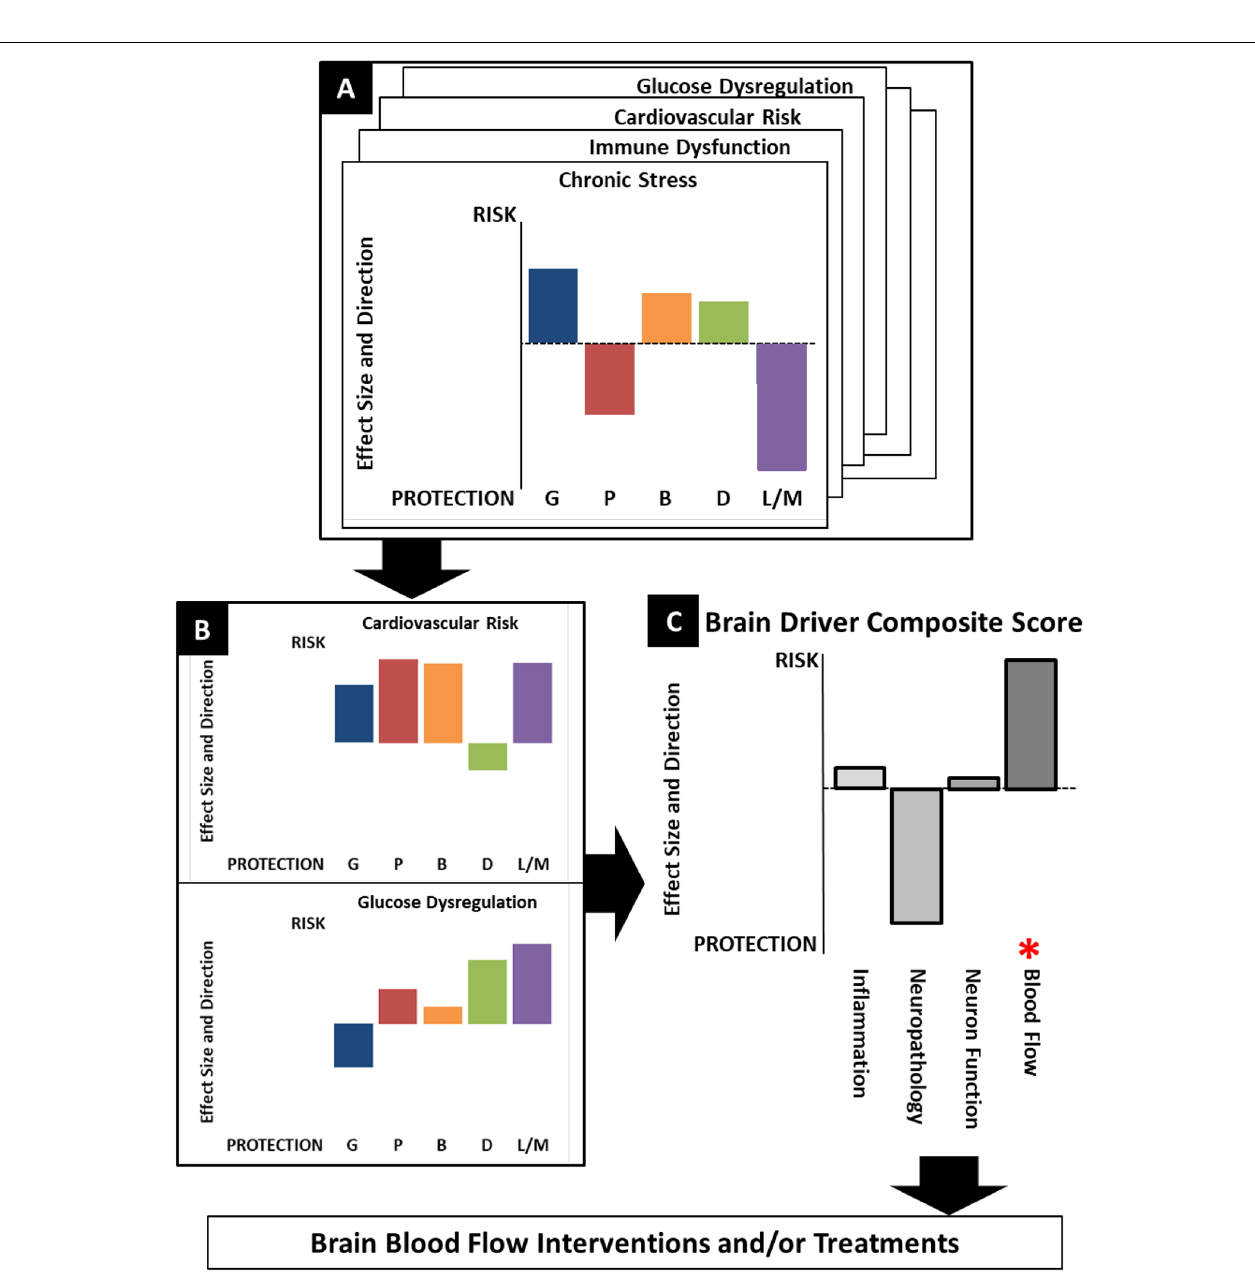
FIGURE 3 | A conceptualization of the Precision Aging model in practice, showing the workflow from assessments of individual risk categories (A) to identifying significant risks (B) which are combined in a composite score that reflects risk for each brain driver. (C) Both the brain driver composite scores and the contributing risk categories lead to the choice of optimal treatments to ameliorate risk factors and to address the at-risk brain driver